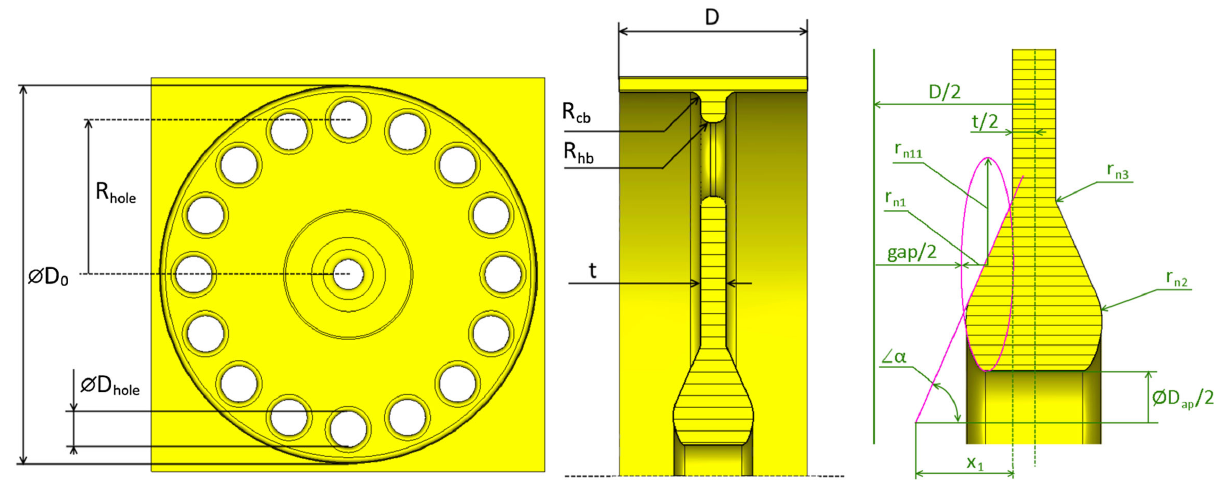
FIG. 10. Profile of the β ¼ 0 . 3 NHS cells with the optimized